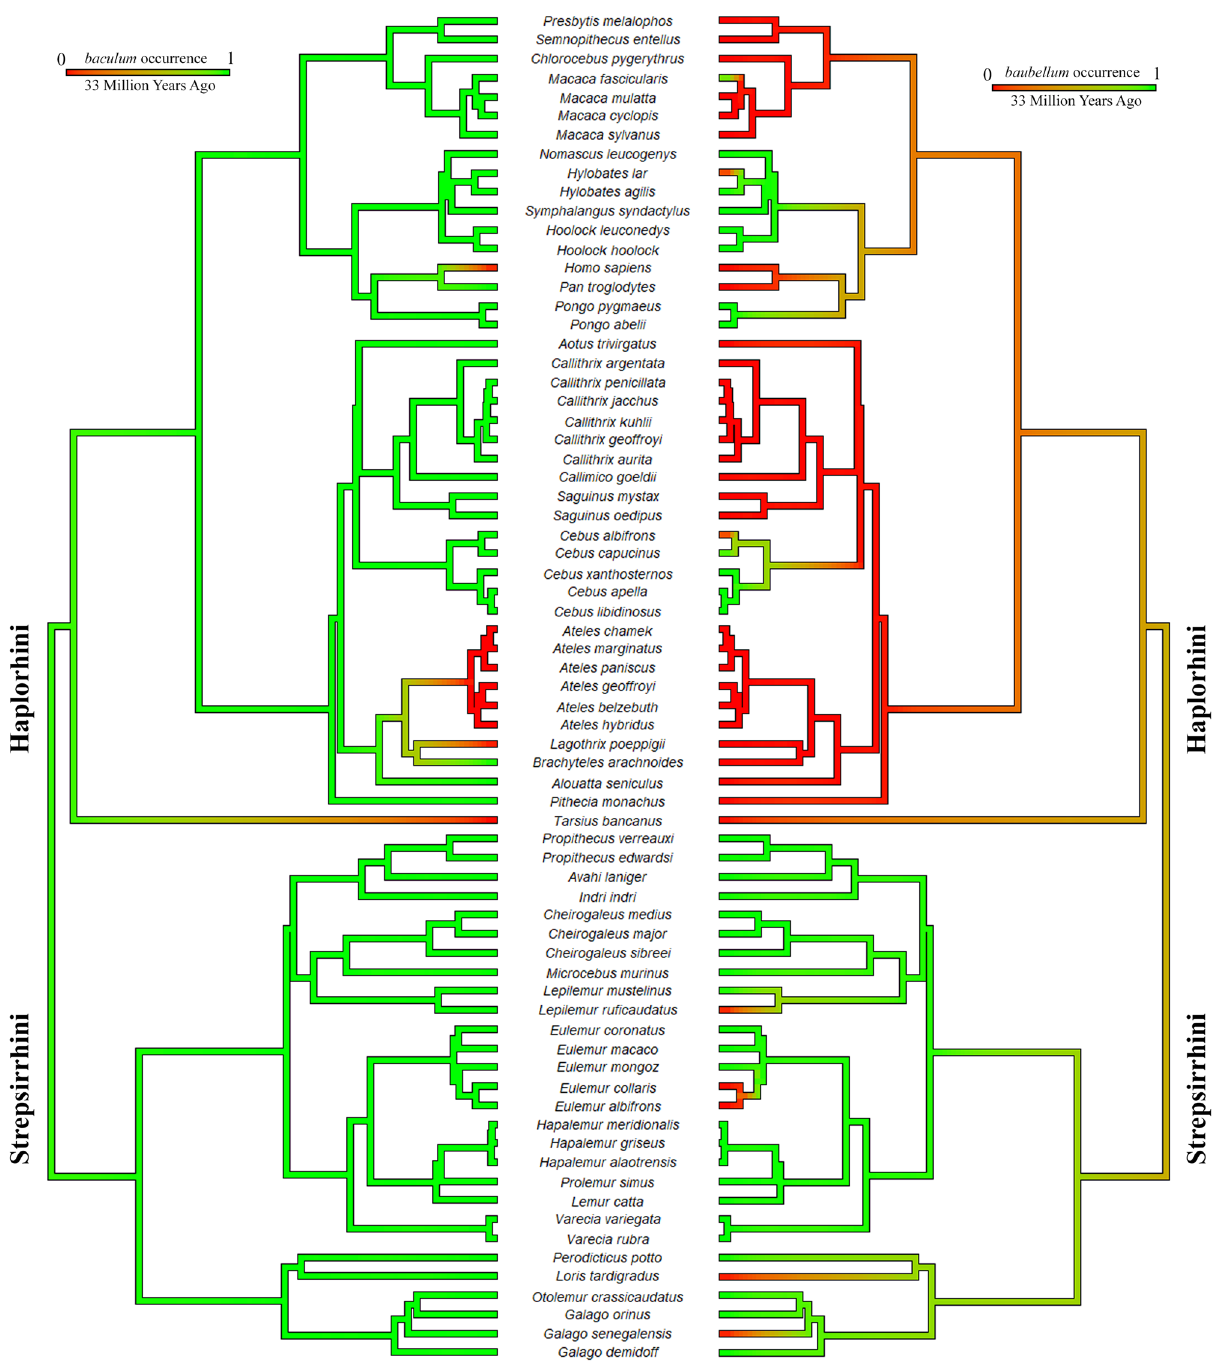
Figure 4. Comparison between baculum and baubellum ancestral character state reconstructions, displayed in aggregate. In this case, only primate species having both baculum and baubellum data were selected to make a comparison. Green indicates a high posterior probability of ossa genitalia presence. The length of the legend also gives a scale for the branch tree length (in this case in Millions of Years Ago). Phylogeny by Springer 71 , dropped. Figure generated in R (v. 4.0.3, https:// www.R- proje ct. org/) 114